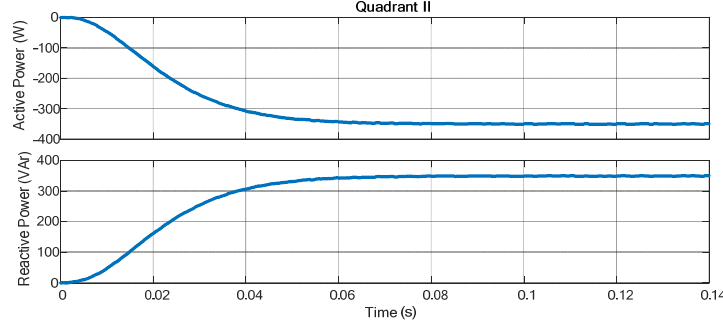
Figure 10. Quadrant 2.